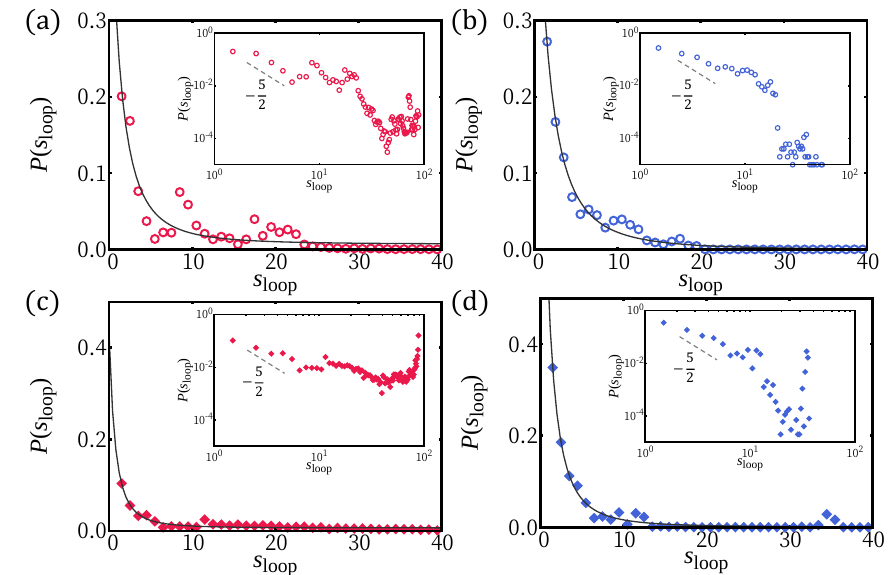
Figure 5. The loop length distributions of H-filament γ > 1 ( a , b ) and γ < 1 ( c , d ) for the two representative values of (cid:101) : weak adsorption regime ( (cid:101) = 0.1) ( a , c ); and strong adsorption regime ( (cid:101) = 1.0) ( b , d ). The envelop of distributions in general follows WLC statistics s − 5/2 (with an offset (cid:46) 1 in s ), which is represented as solid